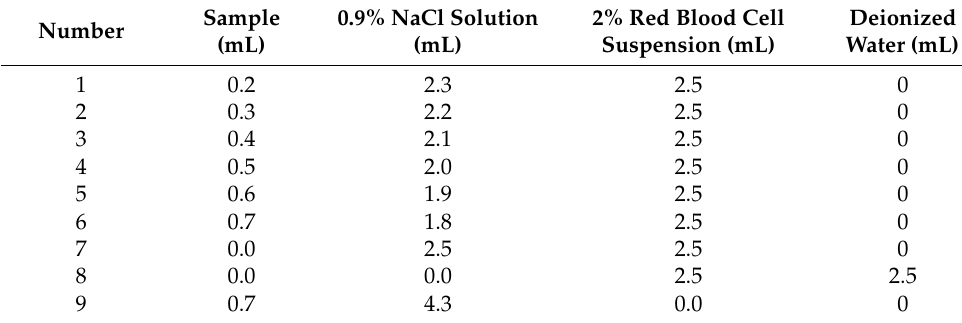
Table 2. Hemolysis experiment design